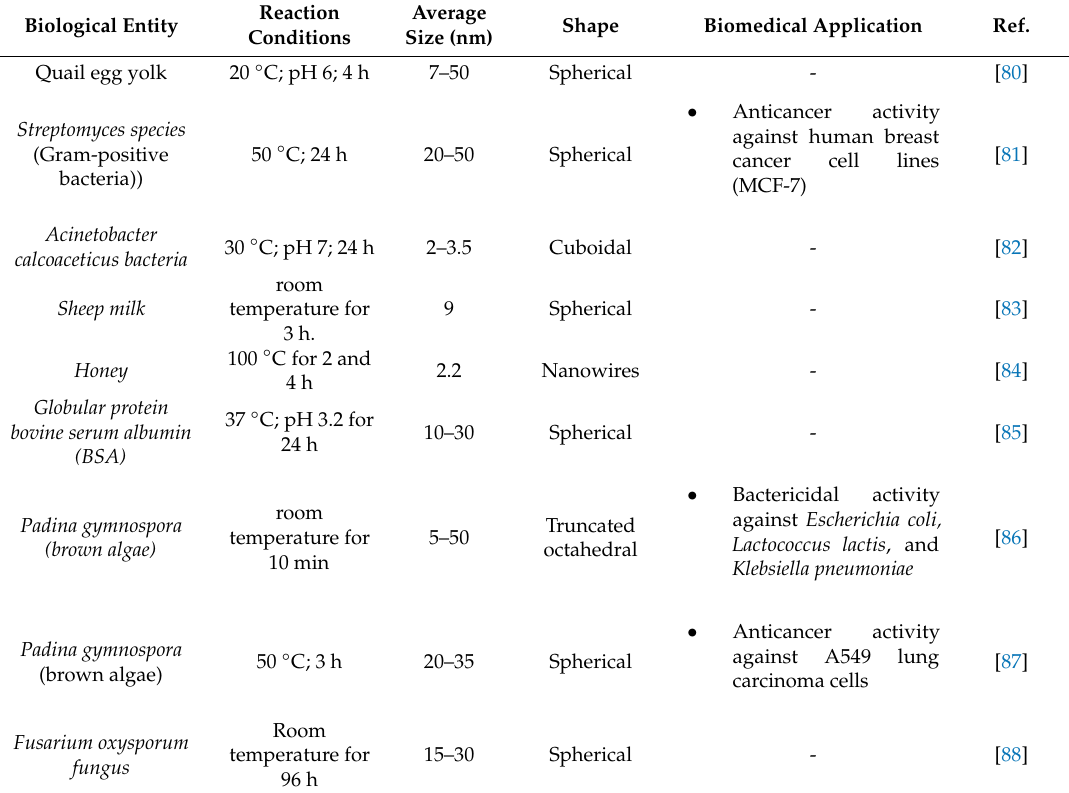
Table 2. Biosynthesis of PtNPs using various biological